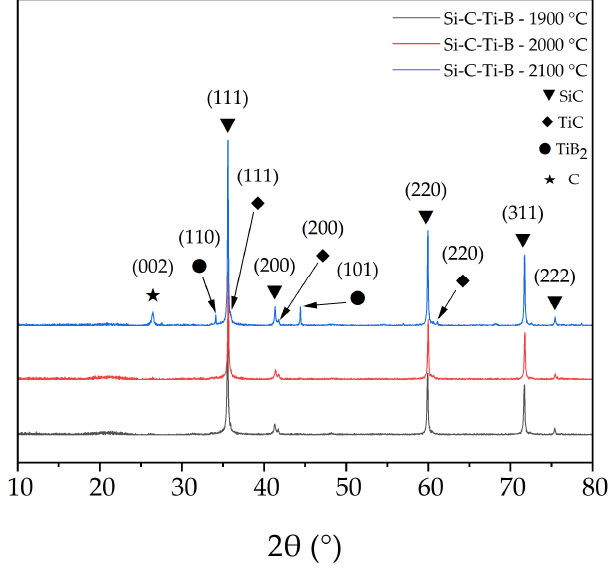
Figure 9. XRD pattern of Si–C–Ti–B fibers after heat treatment at 1900 ◦ C, 2000 ◦ C and 2100 ◦ C under Figure 9. XRD paern of Si−C−Ti−B fibers after heat treatment at 1900 °C, 2000 °C and 2100 °C under argon atmosphere for 1 h. argon atmosphere for 1 h.